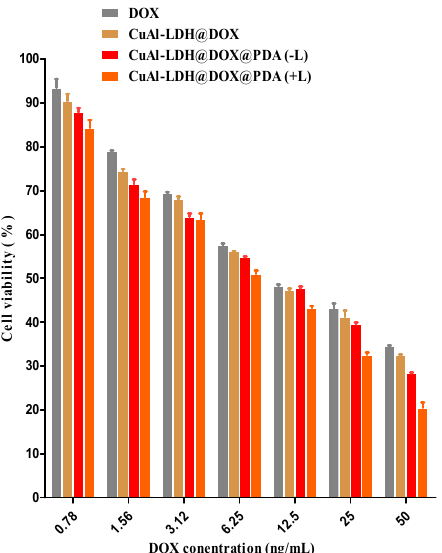
LDH@DOX@PDA with and without light at different drug concentrations. As seen in Fig-